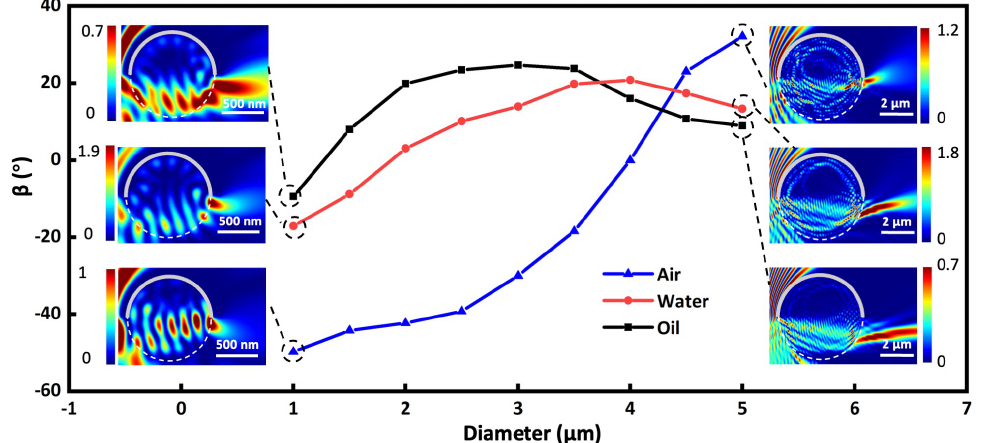
Figure 3. Bending angles ( β ) of the light fields formed in air (blue), water (red) and oil (grey) as a function of particle diameters. The insets are the optical fields of the PHs generated at certain conditions.